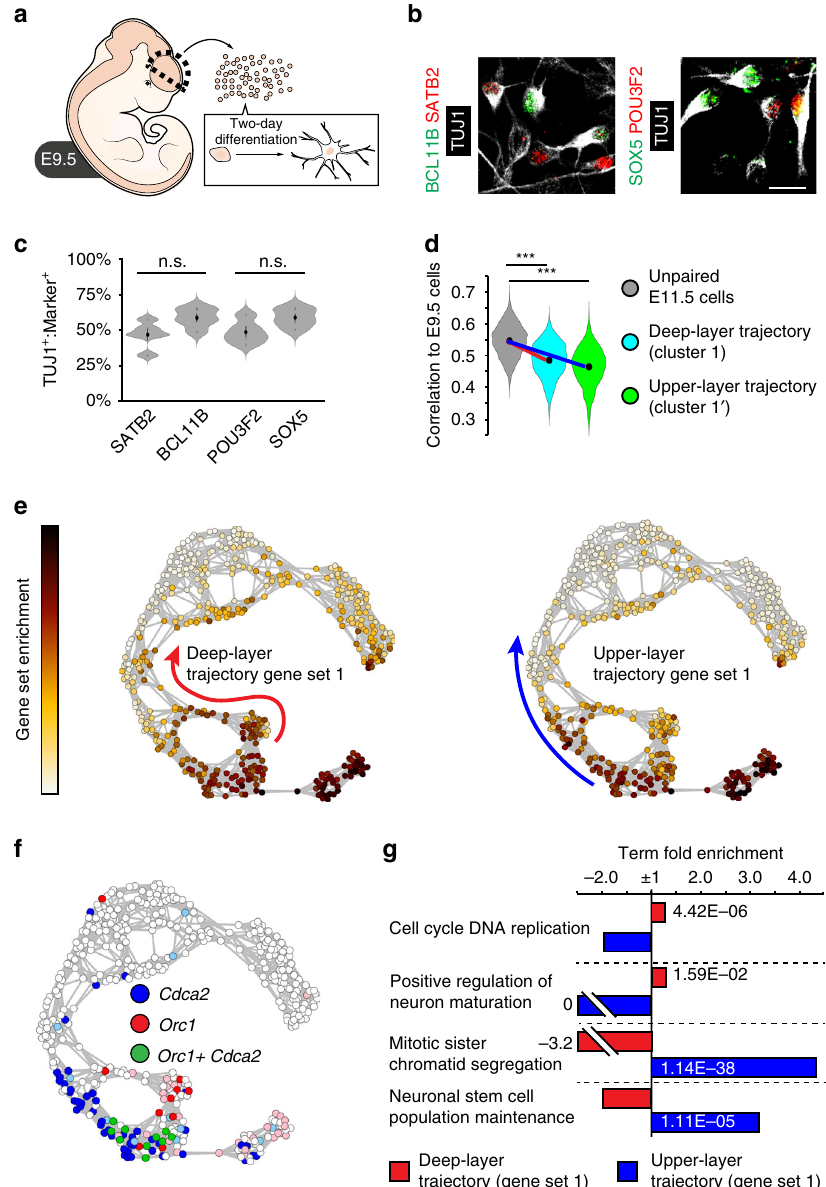
Fig. 3 Lineage-speci fi c gene expression converges in uncommitted progenitors. a Experimental design for cortical in vitro differentiation assays. b , c Immunohistochemistry ( b ) and quanti fi cations ( c ) showing BCL11B, SATB2, SOX5 or POU3F2 expression in TUJ1 + neurons derived from E9.5 cortical cells after in vitro differentiation ( n = 5 biological independent experiments). d Violin plots show correlations between the transcriptomes of E9.5 cells, uncommitted E11.5 cells (grey) or cells committed to deep-layer (cyan; red line; P -value < 1e-300) or upper-layer (green; blue line; P -value < 1e-300) differentiation trajectories. These correlations are based on 46 E9.5 cells 51 uncommitted E11.5 cells, 25 cells committed to deep-layer differentiation and 21 cells committed to upper-layer differentiation. e t SNE-NN maps coloured by WGCNA gene set enrichment scores for deep-layer-trajectory gene set 1 (red line) and upper-layer-trajectory gene set 1 (blue line). f t SNE-NN map coloured by Orc1 (from deep-layer-trajectory gene set 1; pink 20 – 100 RPKM, red >100 RPKM) and Cdca2 (from upper-layer-trajectory gene set 1; light-blue 60 – 100 RPKM, blue >100 RPKM) expression, with co-expressing cells coloured in green. g GO-term fold enrichments and P -values for genes in WGCNA deep-layer-trajectory gene set 1 (red) and upper-layer-trajectory gene set 1 (blue). Violin plots are inset by rings corresponding to the individual data points, a fi lled dot at the group mean and a vertical line showing standard error. Scale bar in ( b ) represents 10 µ m. Statistics based on two-tailed t tests; *** P < 1e-300. P -values for the GO-term analysis are derived from a Binominal test. Source data are provided as a Source Data fi neurons decreased in parallel with SOX2 levels (Supplementary Fig. 6c, d). Together, these experiments functionally con fi rm our bioinformatic identi fi cation of multipotent RGCs and lineage- committed progenitors, which can be separated through their speci fi c expression of cell-surface proteins, or by their distinct expression levels of the transcription factor SOX2 (Fig. 4g).